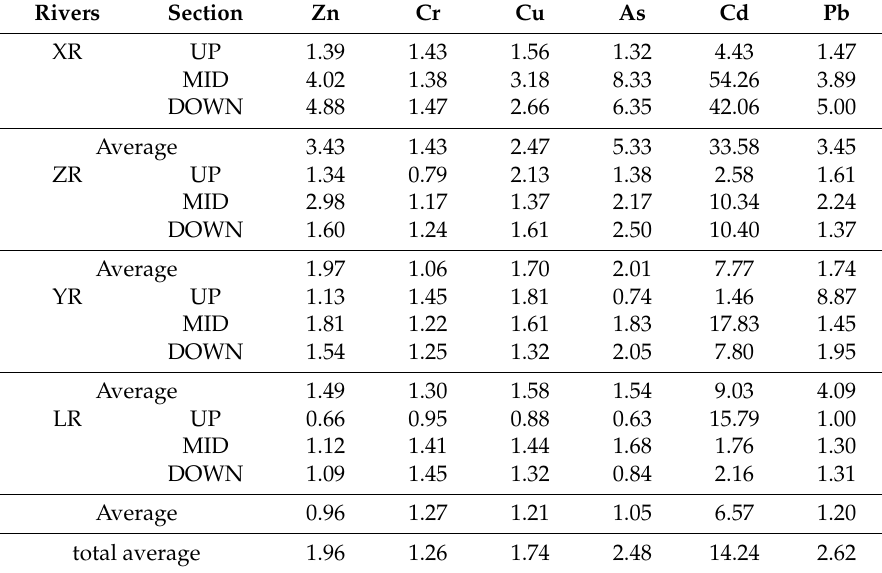
Table 3. EF values of analyzed metals in river sediments. XR—Xiangjiang River; ZR—Zishui River; YR—Yuanjiang River; LR—Lishui